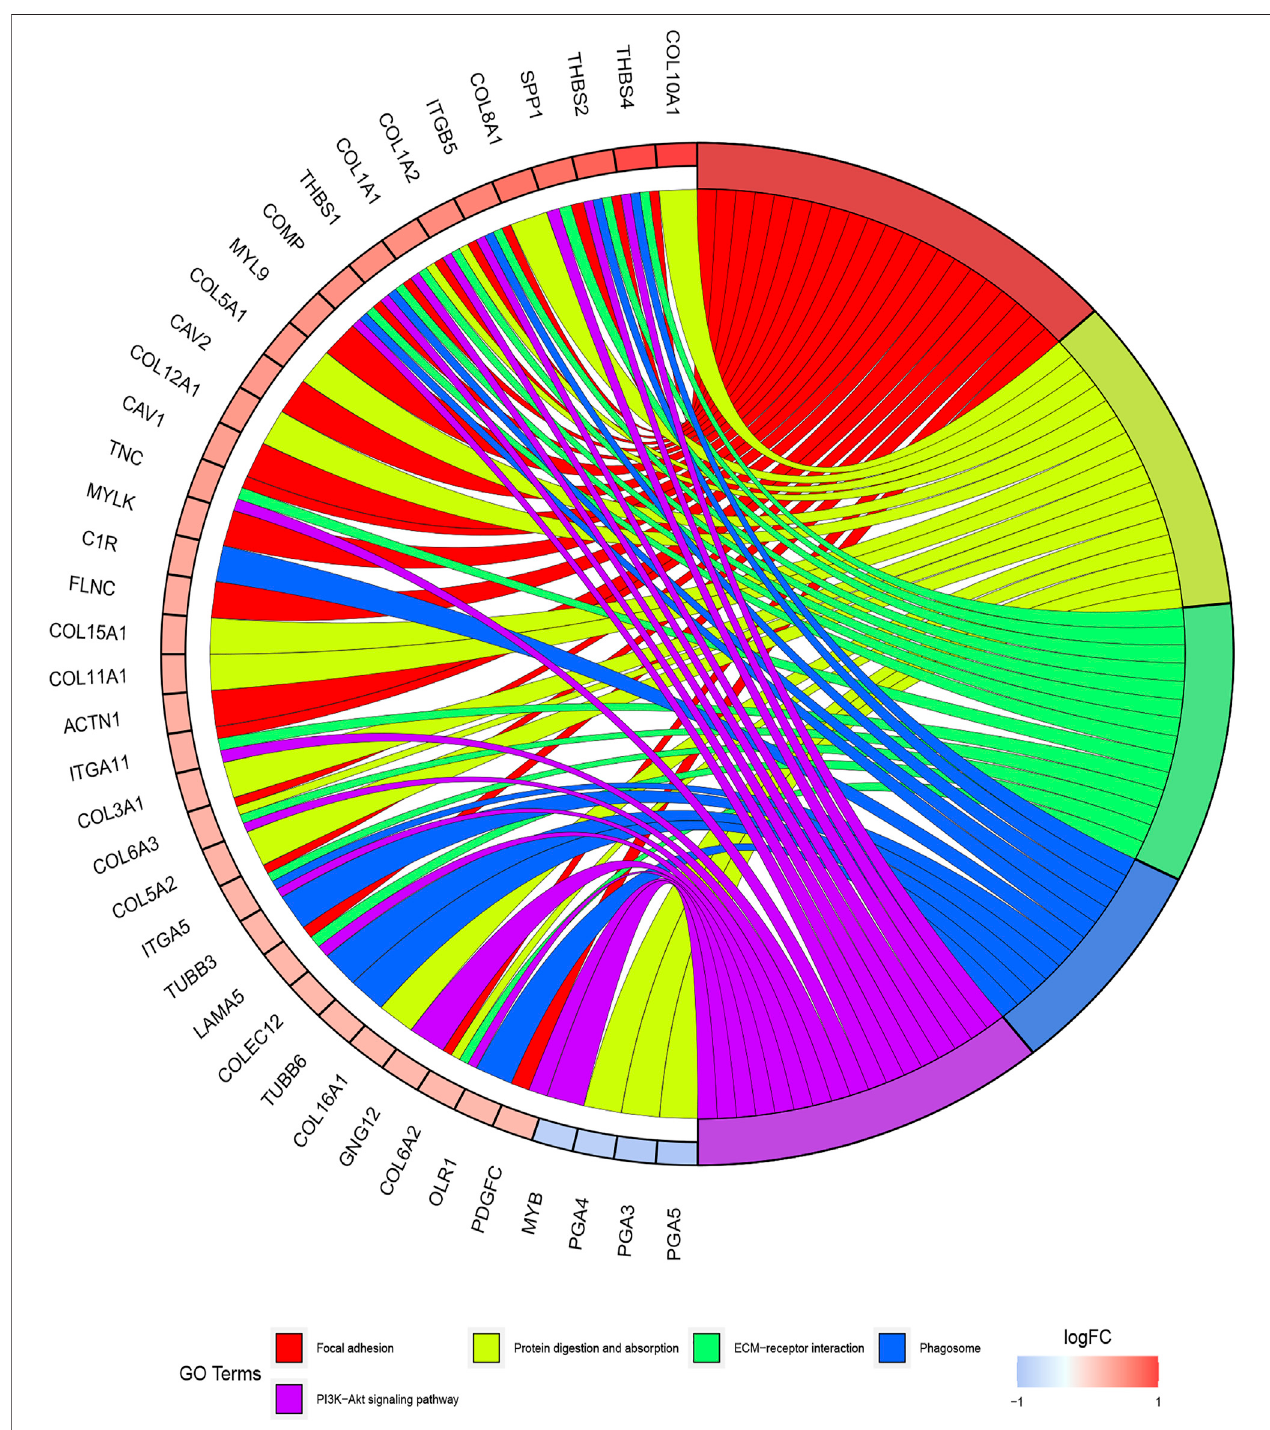
FIGURE 10 | Signi fi cant KEGG pathway determined by circos